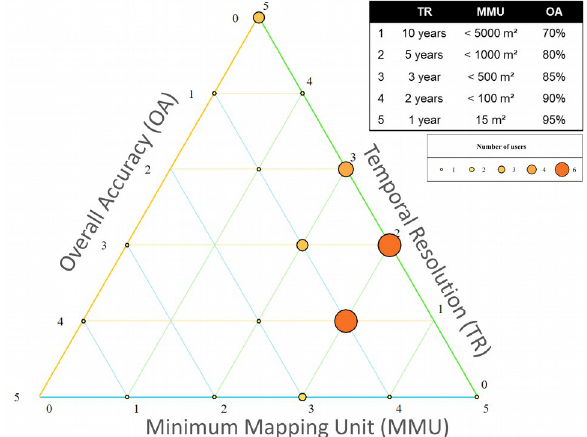
Figure 2: Compromises between objectives as preferred by